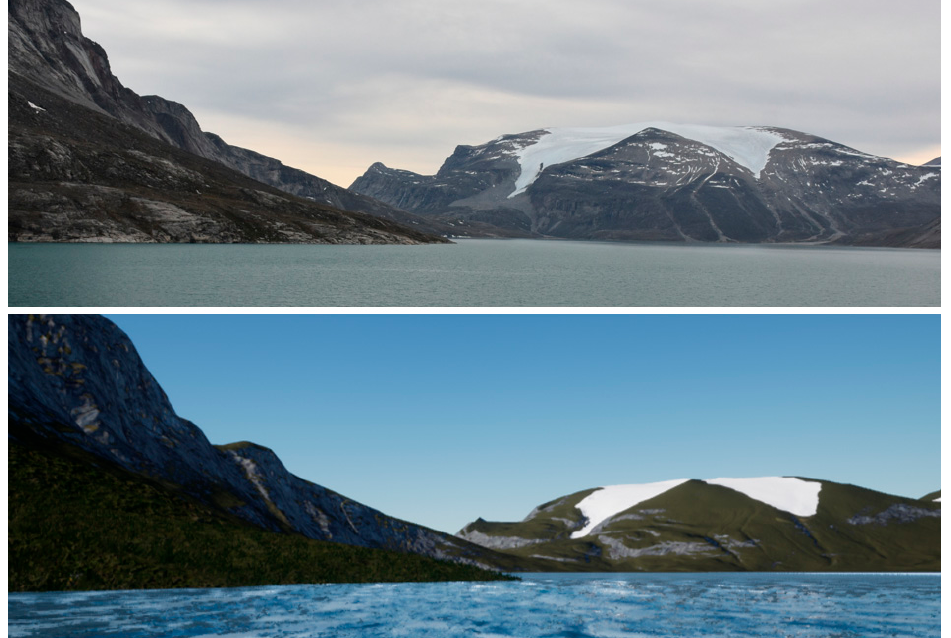
Figure 11. Comparison of the real fjord environment in the photo (top) with the virtual generated environment (bottom).